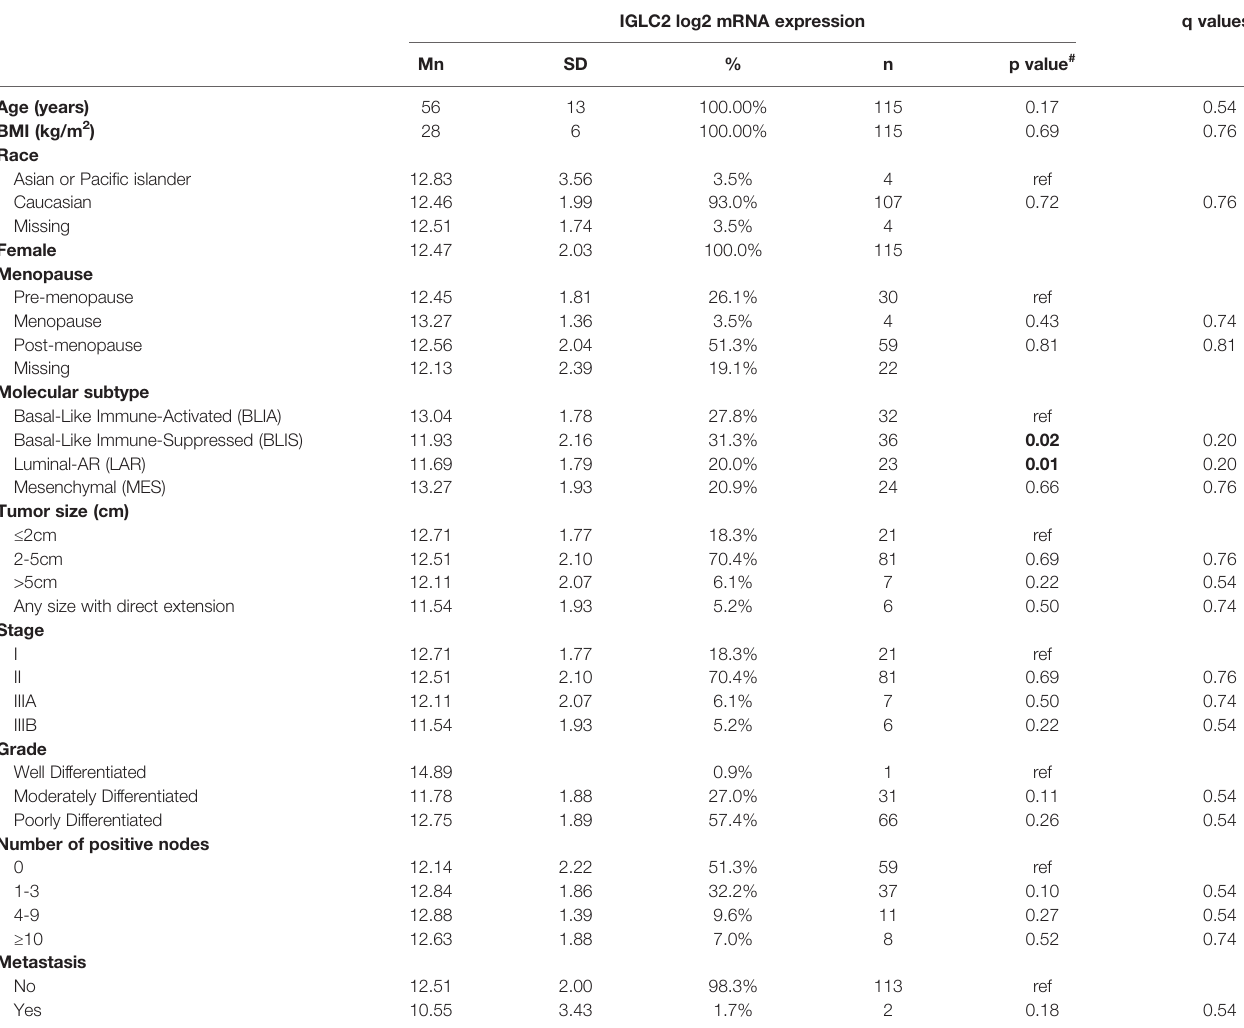
TABLE 2 | Association of IGLC2 mRNA expression and clinical characteristics of TNBC tissues from GSE76275 data set.